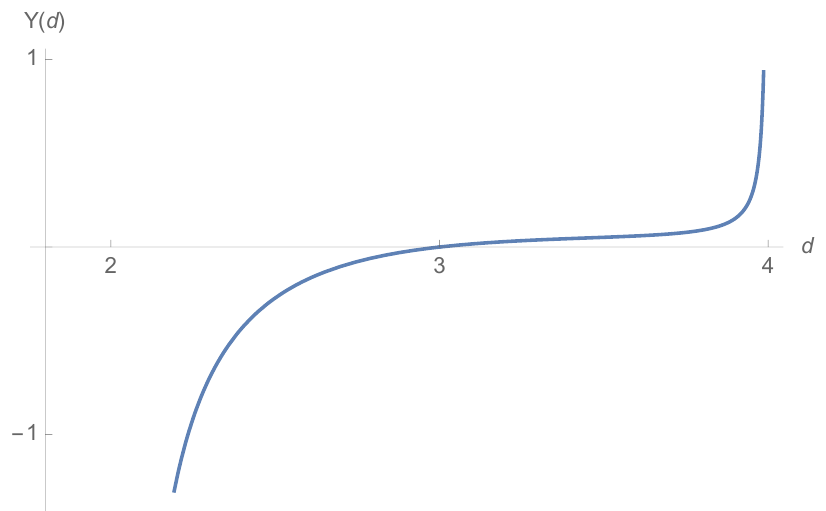
Figure 2 . Υ( d ) is negative for 2 < d < 3 and positive for 3 < d < 4 , vanishes for d = 3 and has poles for d = 2 and d = 4 , increasing monotonically from Υ(2 + ) = −∞ to Υ(4 − ) = + ∞